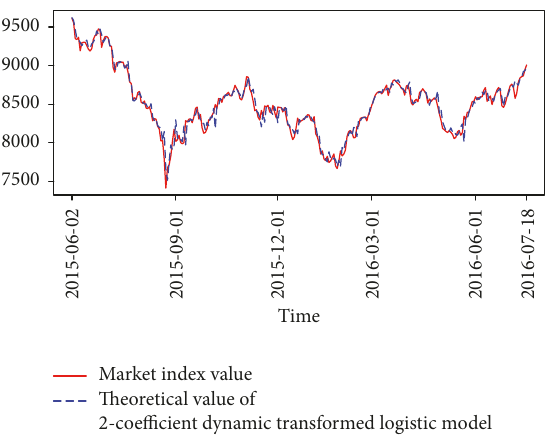
Figure 4: Time plot of raw data and model D fits.